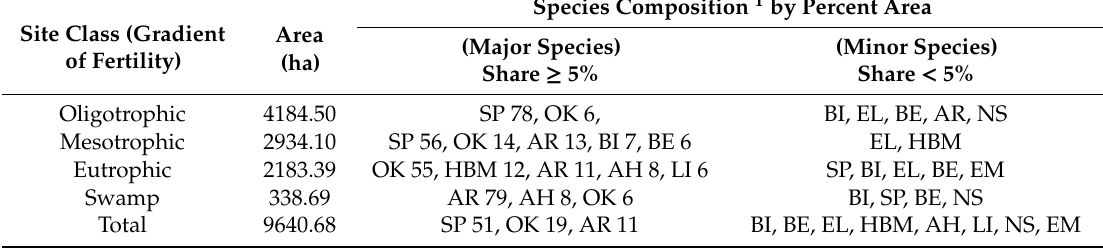
Table 1. Area and species composition of tree stands according to site class in the Niepołomice Forest in